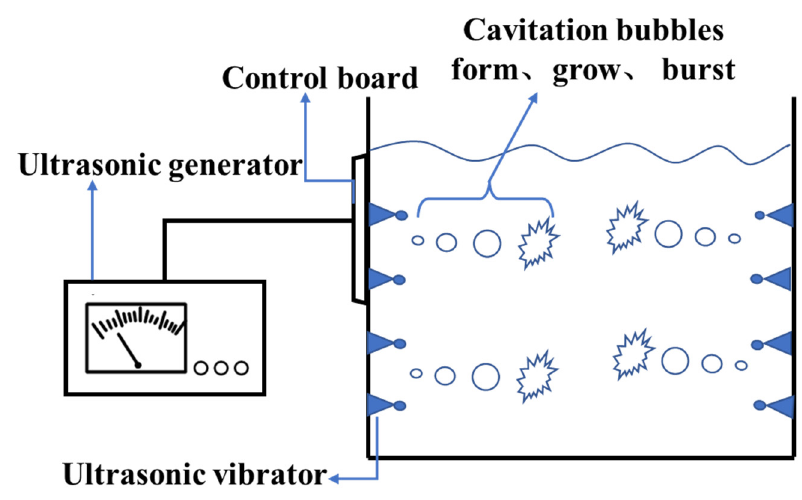
Figure 1. Reaction principle of ultrasound [16].